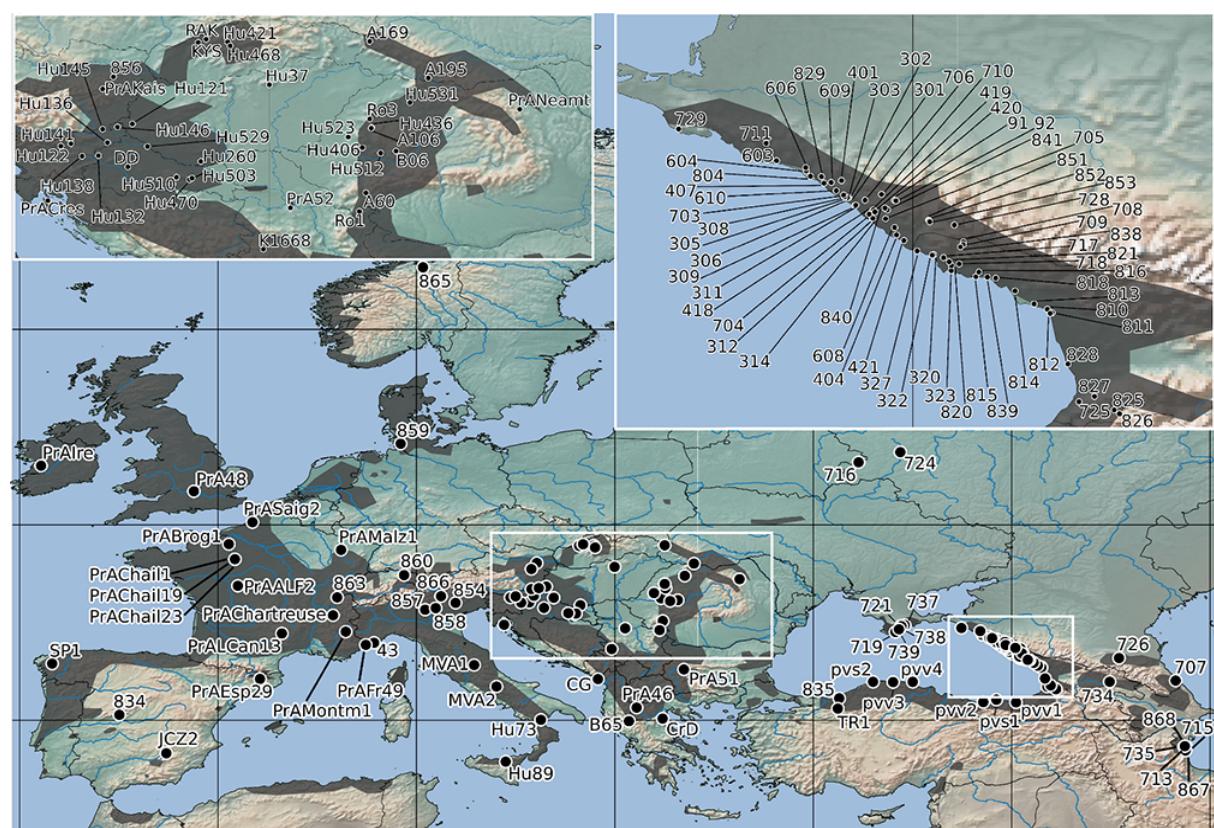
Figure 1 Geographical localities of the Primula vulgaris populations sampled in this study. The distribution range of P. vulgaris is indicated by gray shading on the map, which is drawn after Meusel et al. (1965). The black dots represent individual populations sampled for the genetic study. Population numbers correspond to Table